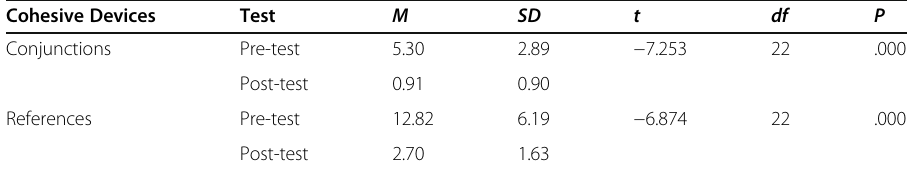
Table 5 Mean errors, standard deviations, and paired-sample T-test results of conjunctions